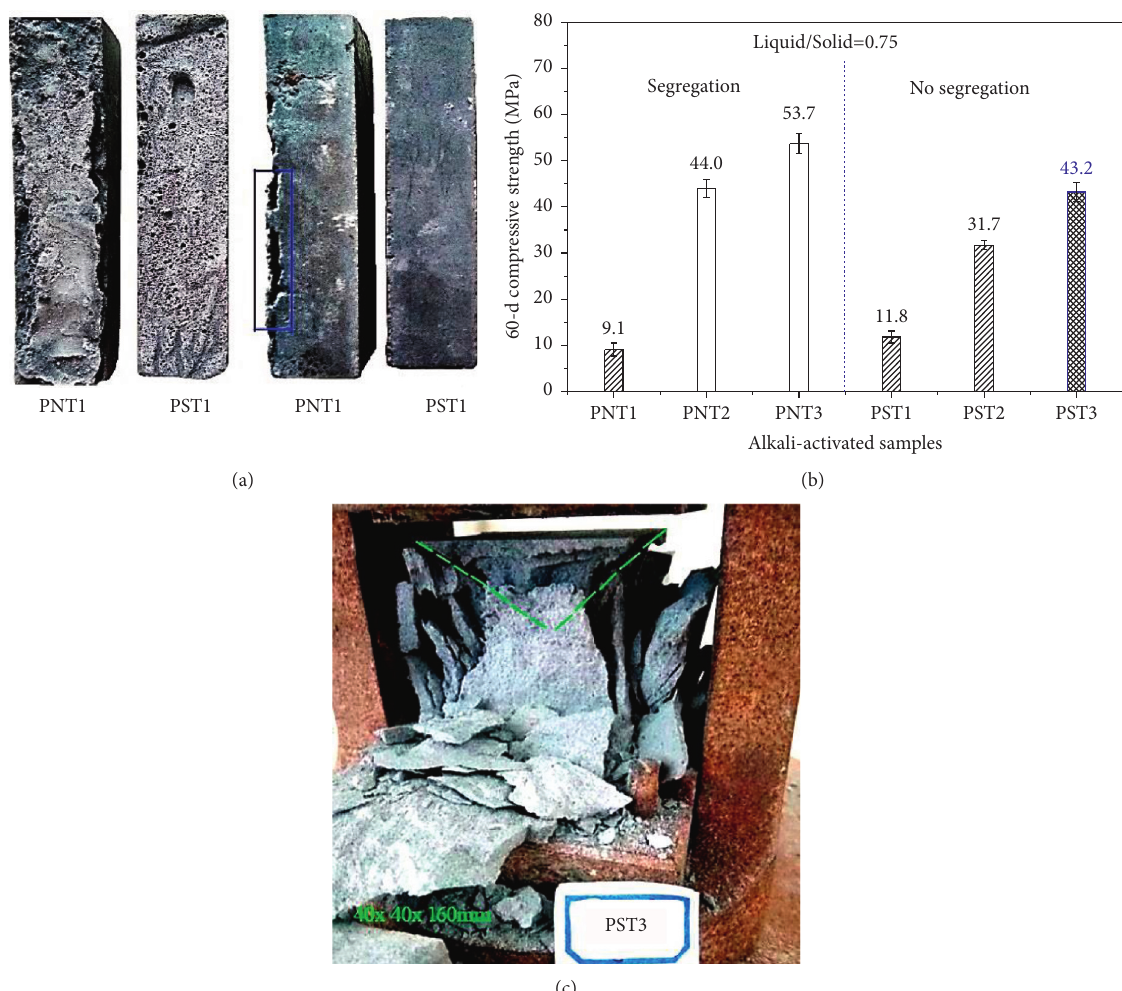
Figure 3: (a) Hardening behaviour, (b) compressive strength, and (c) failure mode of the samples cured for 60d under three designed curing